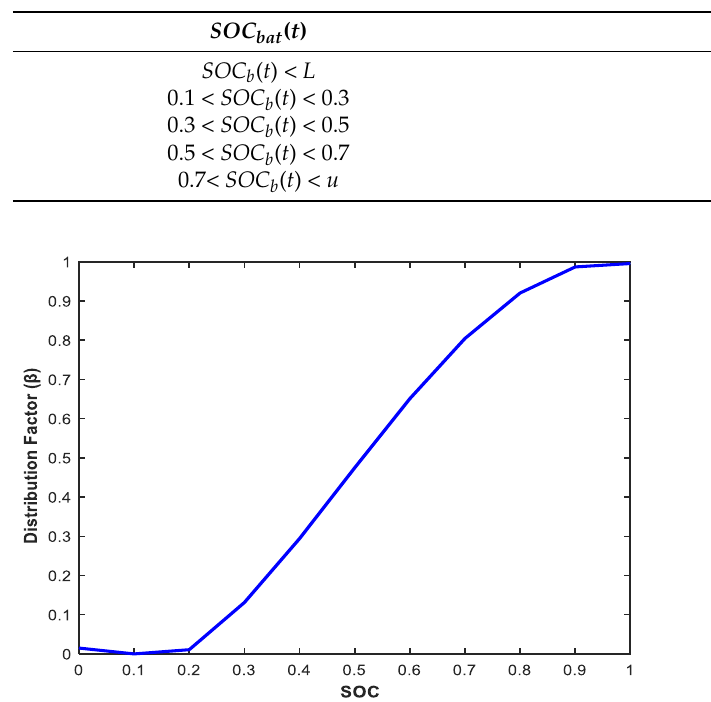
Table 1. Distribution factor values according to battery SOC.